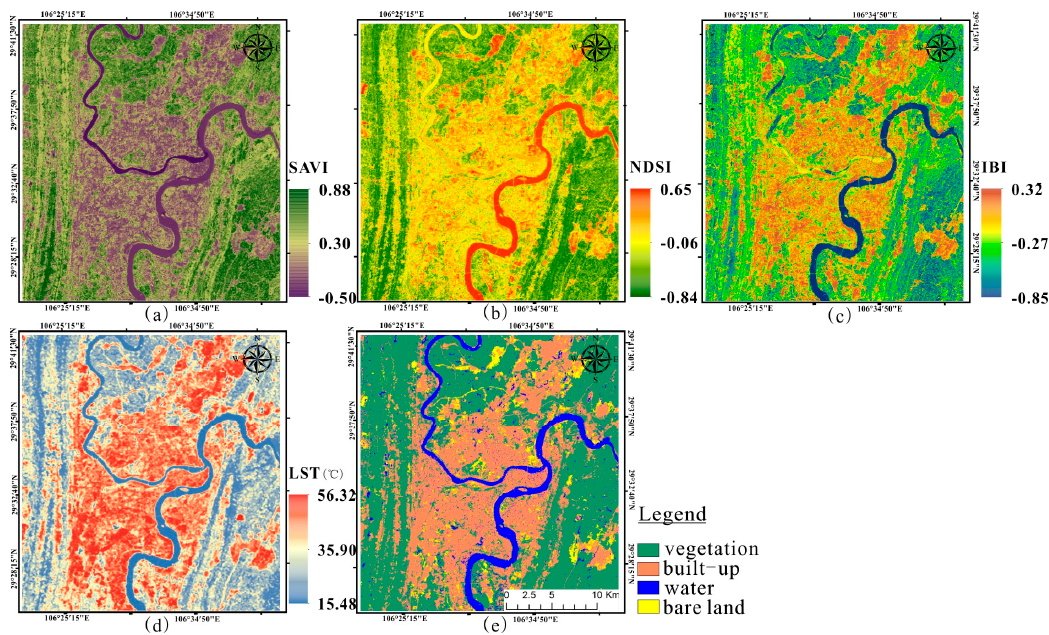
Figure 2. The derivation results of SAVI, IBI, NDSI, LST, and the classification result of the study area at the spatial resolution of 30 m (( a ) SAVI; ( b ) NDSI; ( c ) IBI; ( d ) LST; and ( e ) the classification result of the study area).